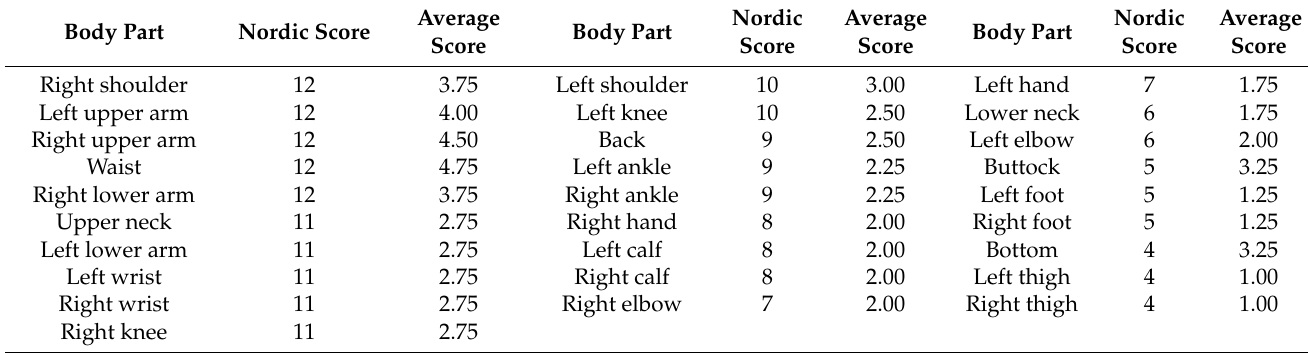
Table 2. Nordic Body Map results.